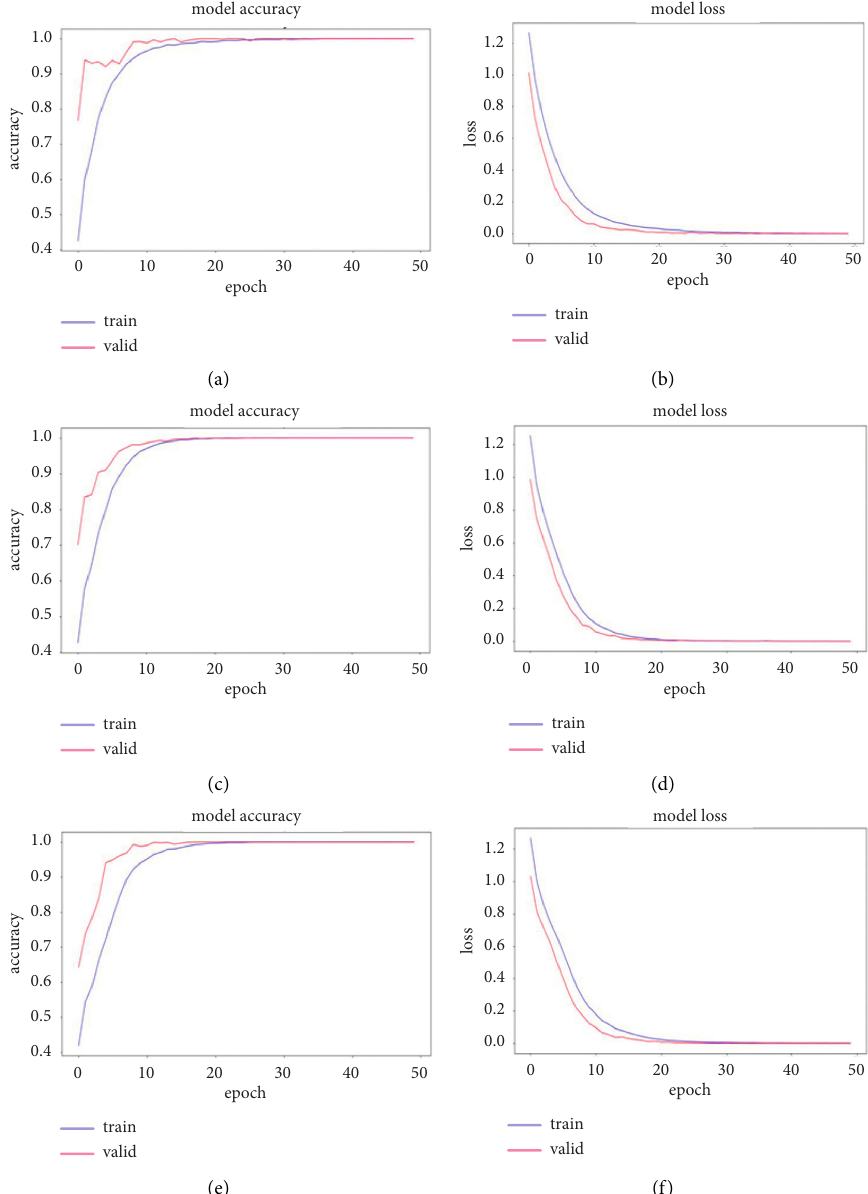
Figure 4: Training-time investigation for CWRU, Jiangnan, and Paderborn datasets. CWRU: (a) accuracy and (b) loss; Jiangnan: (c) accuracy and (d) loss; Paderborn: (e) accuracy and (f) to two for facilitating map generation. The resulting 2D feature maps are shown in Figure 6, wherein different colors represent various fault or normal categories. As shown in Figure 7, after MFFN feature learning, a fault-category clustering effect is observed in contrast to the raw